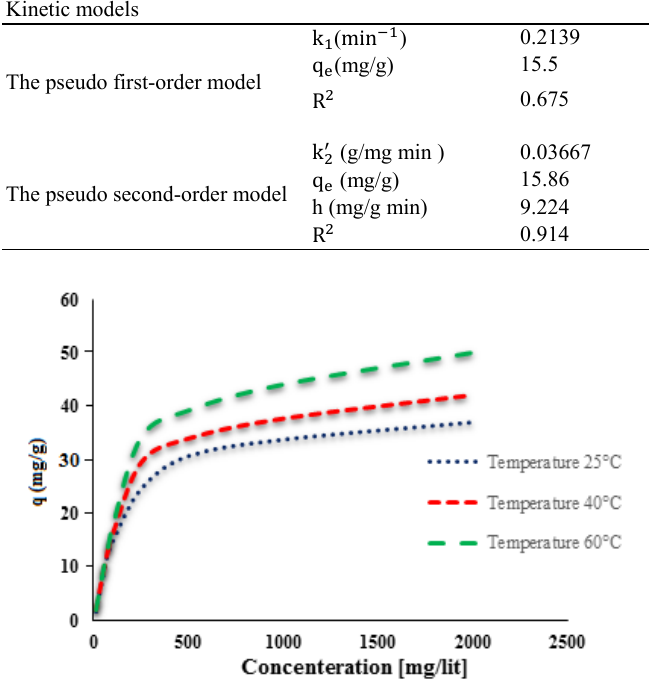
Fig. 4: Effect of initial Cd(II) ion concentrations on the amount of Fig. 4 Effect of initial Cd(II) ion concentrations on the amount of sorption.